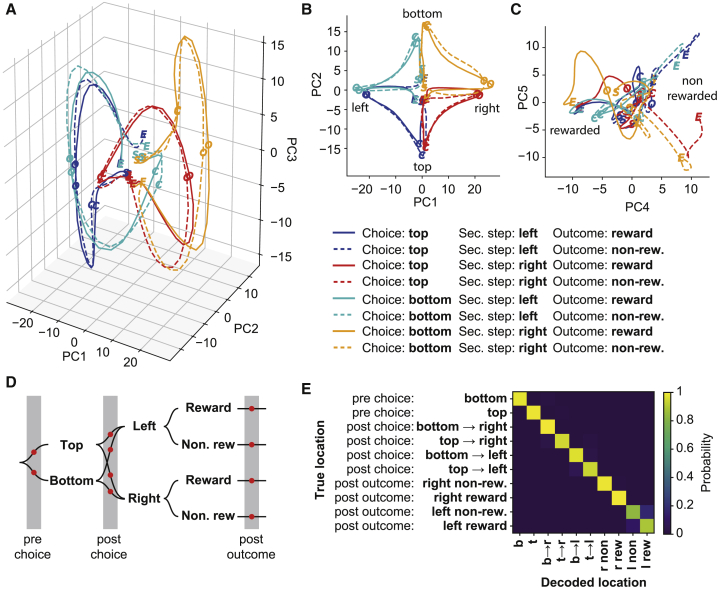
ACC Represents the Full State-Action Space(A–C) Projection of the average population activity for different trial types into the low-dimensional space that captures the most variance between trial types. Trial types were defined by the eight combinations of choice, second step, and trial outcome. Letters on the trajectories indicate the trajectory start (S; 1,000 ms before choice), the choice (C), outcome (O), and trajectory end (E; 1,000 ms after outcome). (A) Three-dimensional plot showing projections onto first three principal components. (B) Projection onto PC1 and PC2, which represent second-step and choice, respectively. (C) Projection onto PC4 and PC5, which differentiate trial outcomes.(D and E) Decoding analysis assessing how accurately ACC population activity differentiates between different locations in task’s state-action space. (D) Diagram showing the ten different locations (red dots) in the tasks state-action space used in the decoding analysis. (E) Confusion matrix showing the cross-validated probability of decoding each location given the actual location the activity was from.